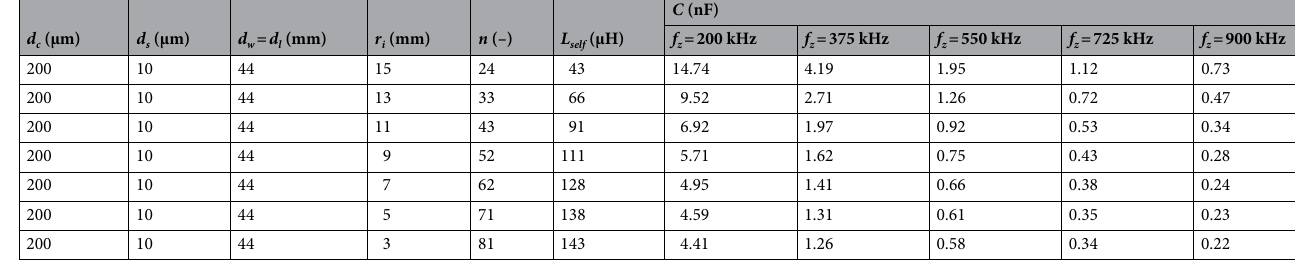
Table 1. Parameters of resonators with outer radius r o = 20 mm.